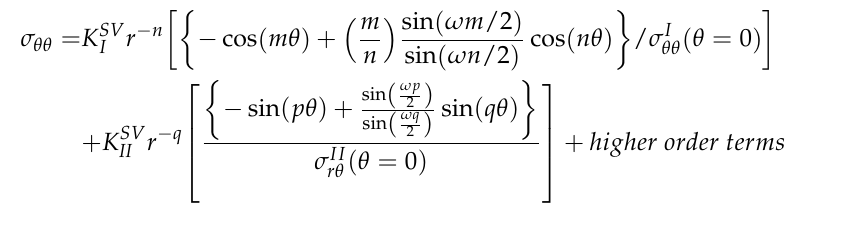
and , and the values of I